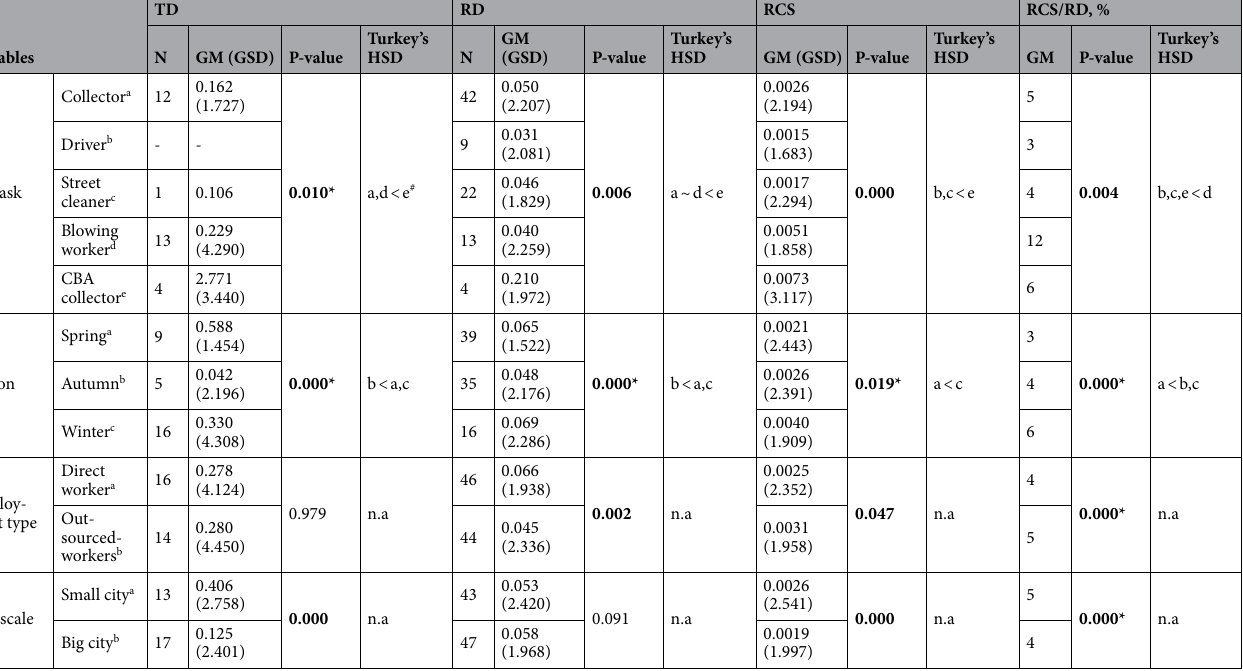
Table 4. TD, RD and RCS levels (µg/m 3 ) according to occupational and working environment factors. Bold letters indicate that the difference is statistically significant. TD total dust, RD respirable dust, RCS respirable crystalline silica, CBA used coal briquettes ash. # Number of TSP sample in street cleaner is less than 2, so it is not included in the post-hoc analysis. *Robust Tests of Equality of Means (Welch test).